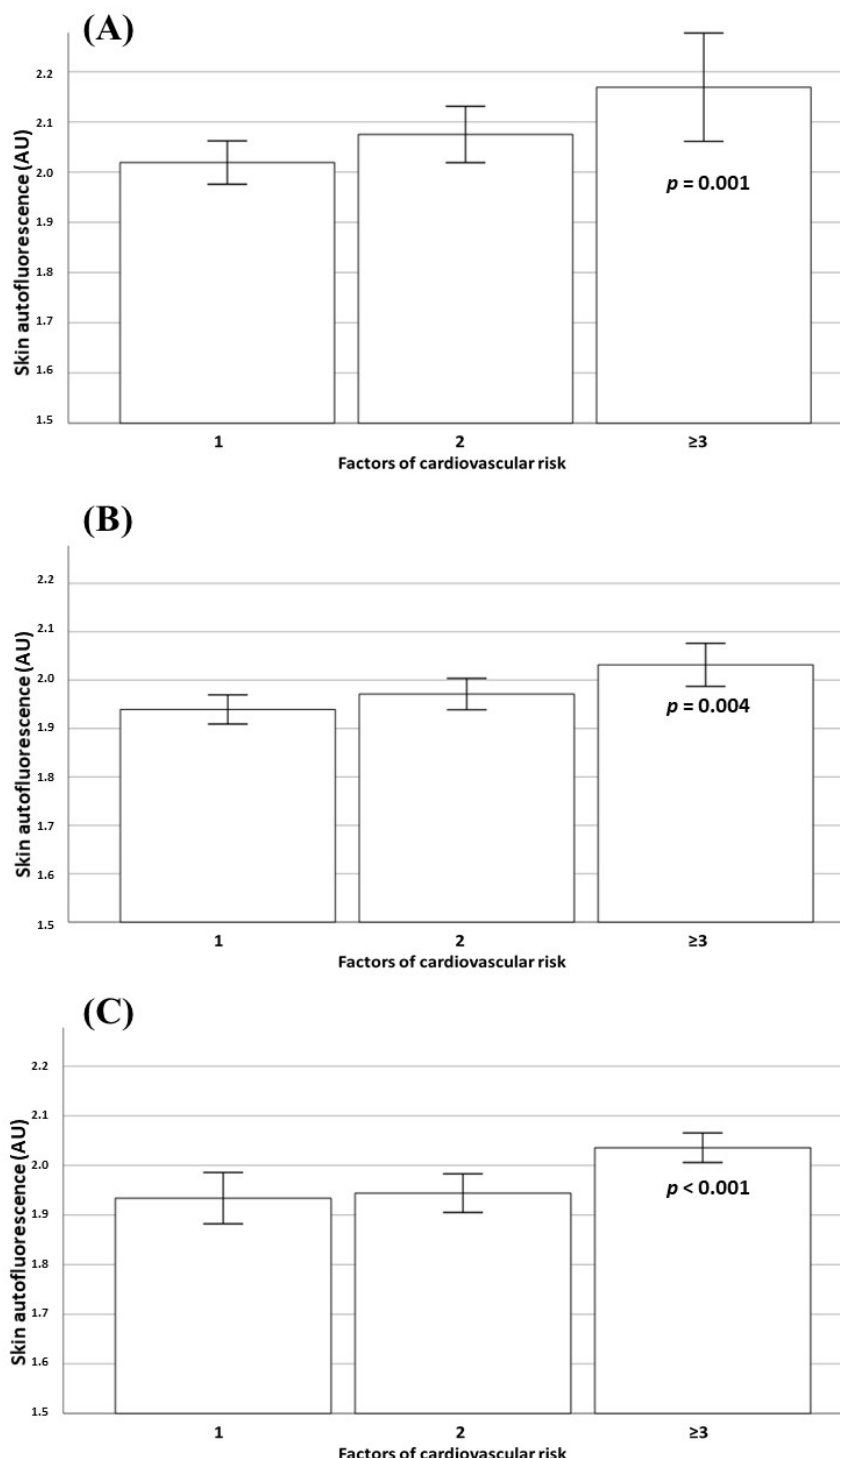
Figure 3. Results of the skin autofluorescence values in subjects with normal weight ( A ), overweight ( B ) and obesity ( C ) according to the number of cardiovascular risk factors (history of smoking habits hypertension, dyslipidemia and prediabetes).